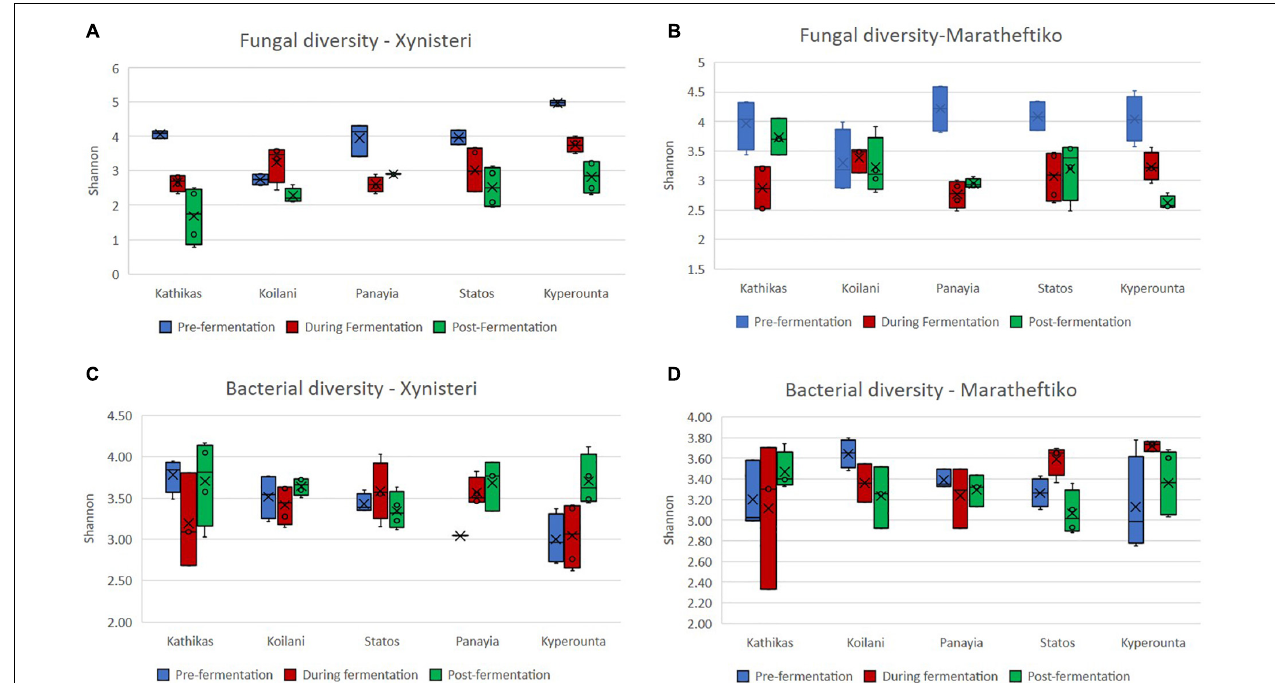
FIGURE 2 | Investigation of the microbial alpha diversity based on the Shannon index in grape juice and must samples for the terroirs Kathikas, Koilani, Kyperounta, Panayia, and Statos during the three stages of fermentation (pre-fermentation, during fermentation, and post-fermentation). (A) Fungal diversity of the variety Xynisteri; (B) fungal diversity of the variety Maratheftiko; (C) bacterial diversity for the variety Xynisteri; (D) bacterial diversity for the variety Maratheftiko. The blue box-plots represent the fungal or bacterial diversity pre-fermentation. The red box-plots represent the fungal or bacterial diversity during fermentation. The green box-plots represent the fungal or bacterial diversity post-fermentation. The o symbols represent the outliers from the median and x symbols the brand means. Statistical analysis was performed using Kruskal-Wallis